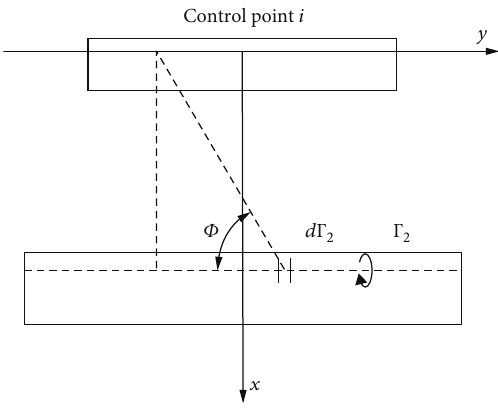
Figure 3: De fi nition of the angle describing the segment of the bound vortex and the vector.